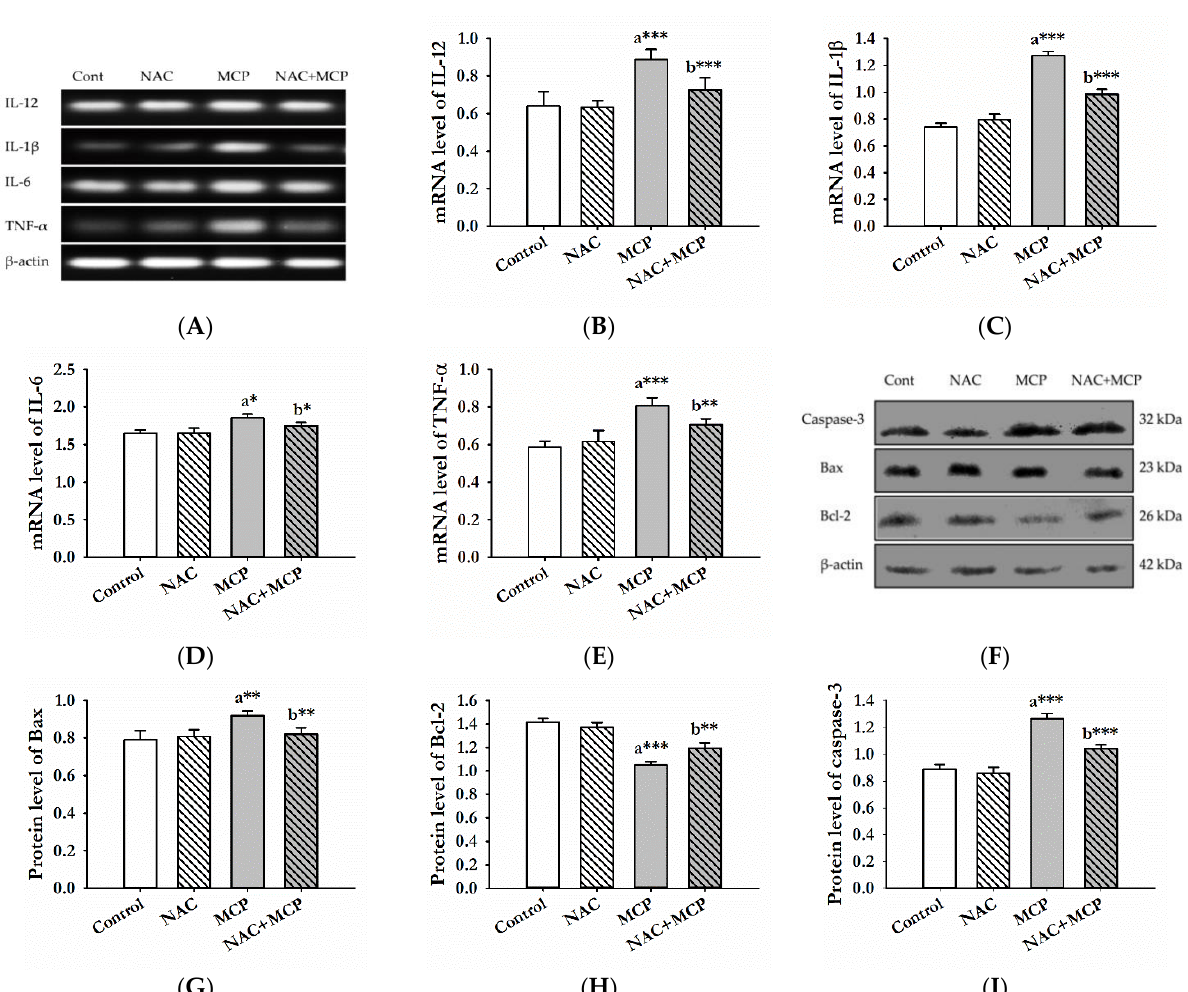
Figure 2. NAC pre-treatment attenuates inflammation and apoptosis in the liver of MCP-exposed rats. ( A ) Representative image of mRNA expression of IL-12, IL-1β, IL-6 and TNF-α. ( B – E ) Relative mRNA level of different pro-inflammatory markers with respect to β-actin. ( F ) Western blotting showing the changes in protein expressions of Bax, Bcl-2 and caspase-3 in control and experimental groups. ( G – I ) Relative protein levels of Bax, Bcl-2 and caspases-3 with respect to β-actin. The values represented are the values represented are mean ± S.D. (N = 3). a as compared to the control group; b as compared to MCP-exposed group. * p < 0.05, ** p < 0.01, *** p < 0.001 significantly different.